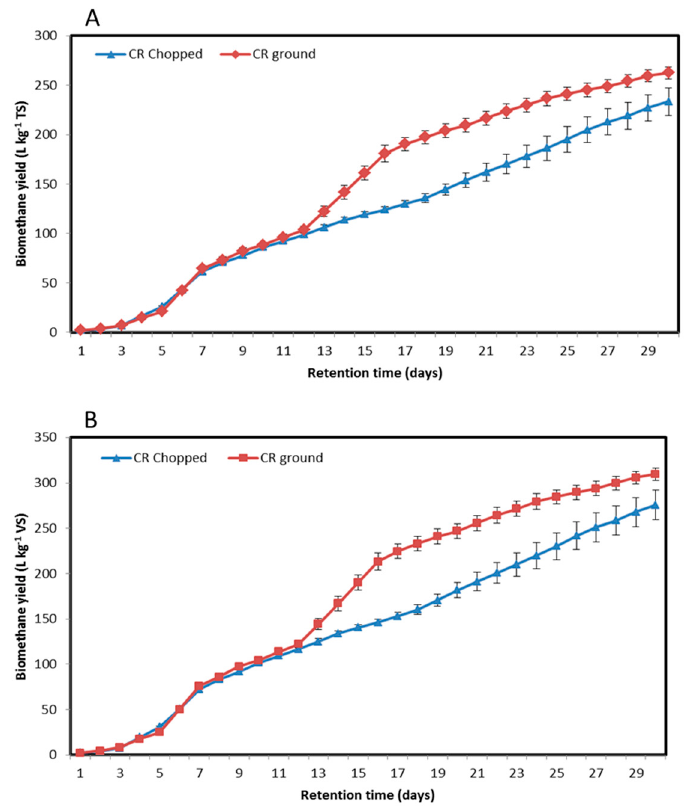
Figure 3. Cumulative biomethane yields form 5 mm chopped and <500 µ m ground corn residue. ( A ) in TS basis; ( B ) in VS basis.